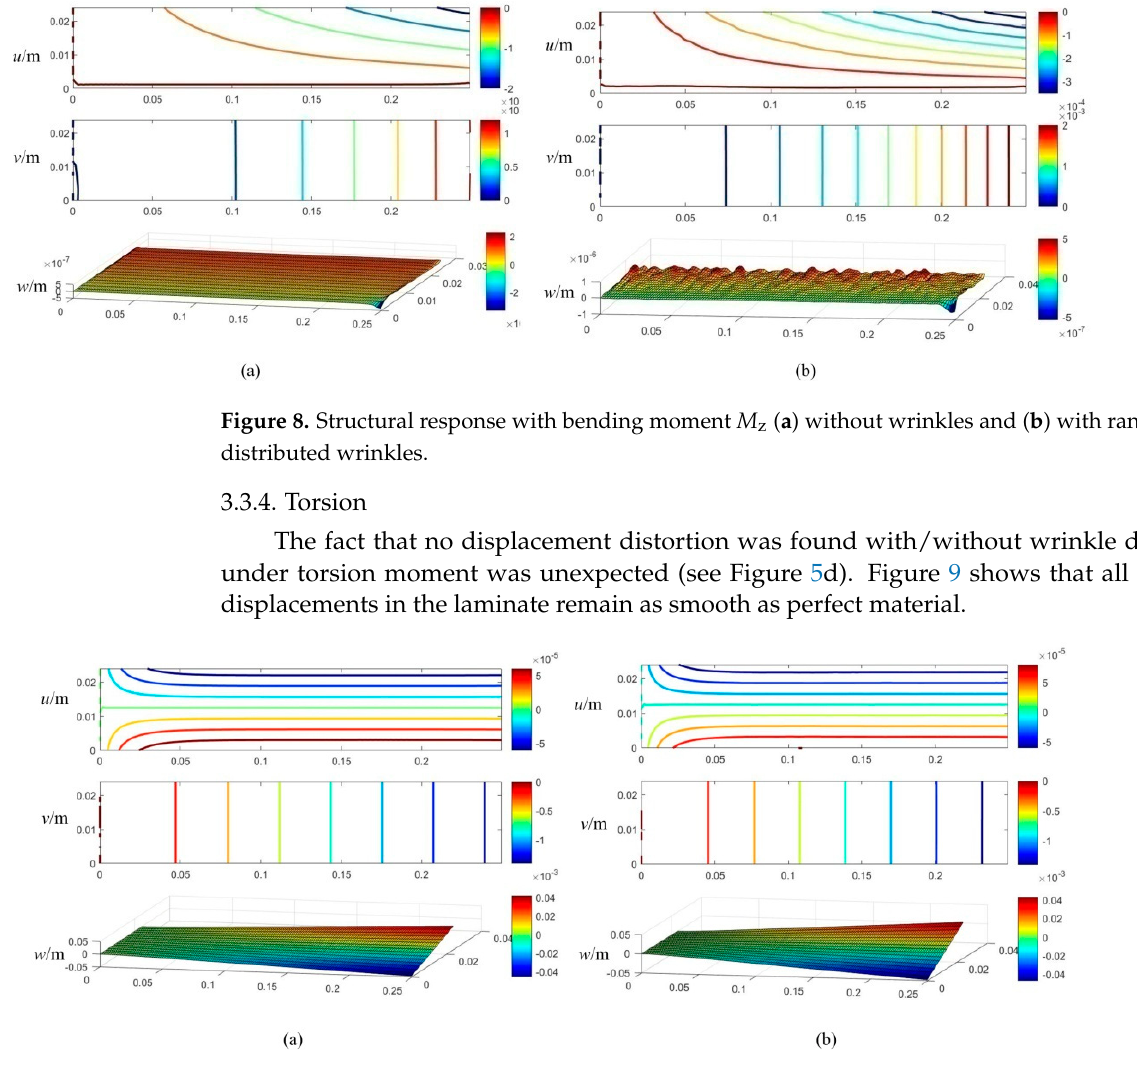
Figure 9. Structural response with torque around x-axis ( a ) without wrinkles and ( b ) with randomly distributed wrinkles.